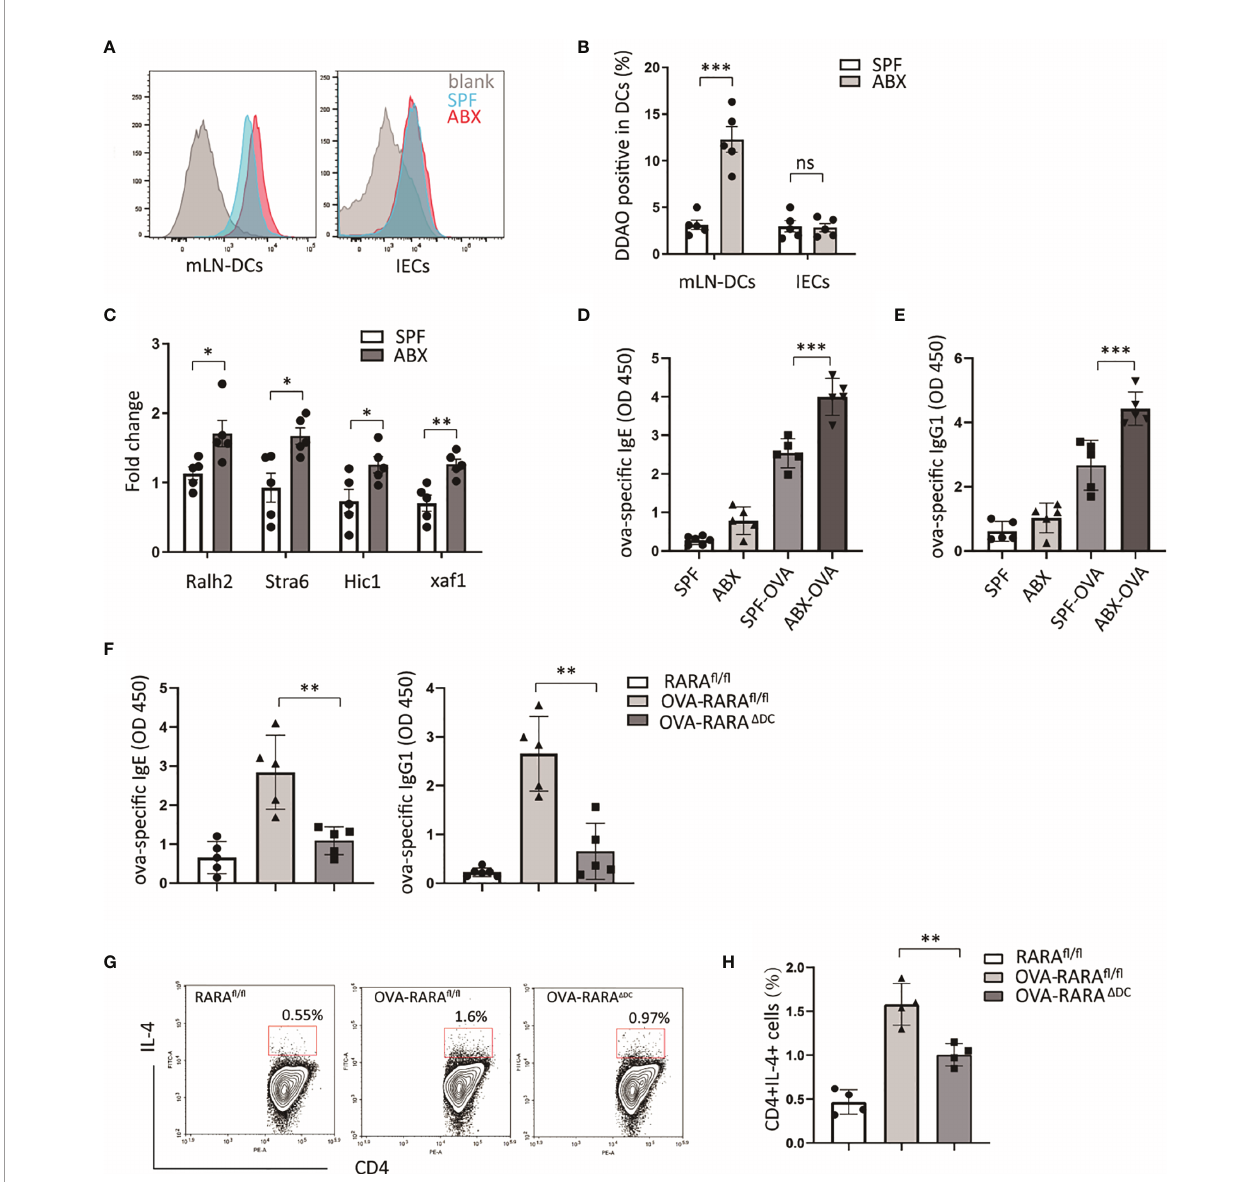
FIGURE 1 | RA signaling is required for gut dysbiosis-induced allergy. (A, B) RA signaling assessment. b -galactosidase expression was detected by its substrate DDAOG using fl ow cytometry. DCs (gating on cd11c positive) from mLN tissue and intestinal epithelial cells (IECs) isolated from RARE-lacZ transgenic mice were analyzed. (C) RT-PCR measurement of retinoic acid signaling-related genes, relative to Gadph, in mLN tissue. (D – F) RAR a fl / fl and RAR a D DC mice, after treated with ova intragastric administration, ova-speci fi c IgE and IgG1 levels in serum were detected by ELISA. And the frequency of CD4(+)IL4(+) cells in mLN were measured by fl ow cytometric analysis. Graph shows mean and SEM. Five mice per group from at least two independent experiment. Data were analyzed by unpaired Student ’ s t-test (A – C) and one-way ANOVA (D – H) . *p < 0.05, **p < 0.01, ***p < 0.001, ns, not signi fi